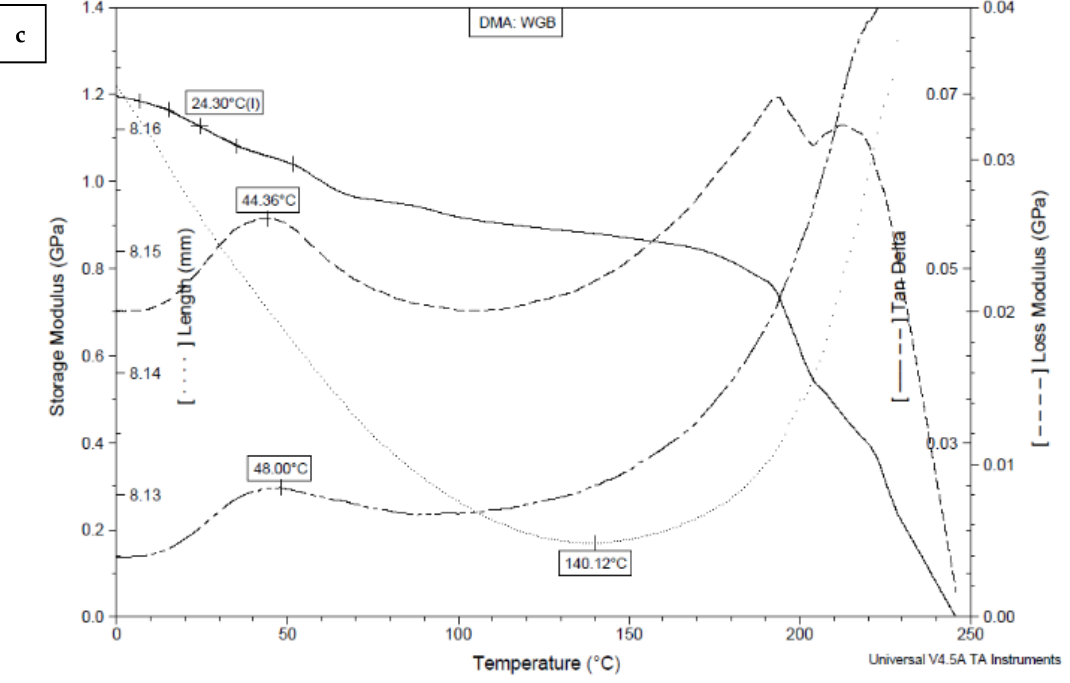
Figure 6. The viscoelastic curves and parameters of samples: ( a ) HS, ( b ) HS-C + WGB, and ( c ) WGB at 10 Hz of oscilla- tion.